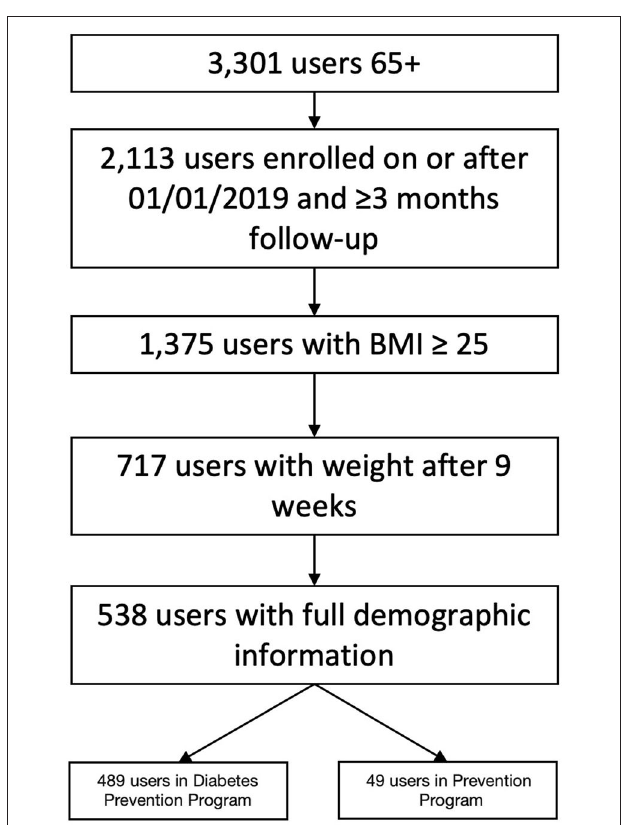
FIGURE 1 | Users based on inclusion and exclusion criteria.